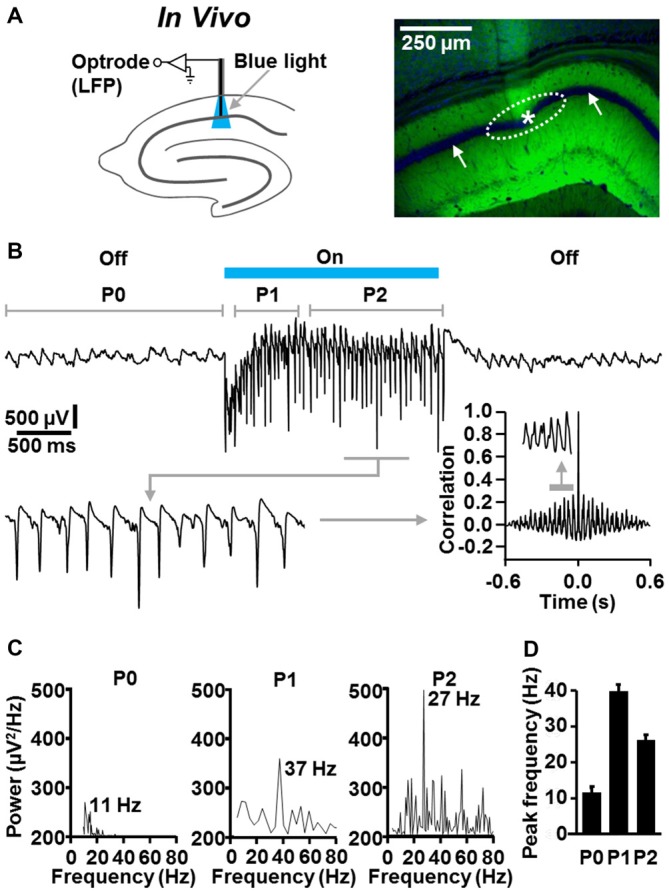
Temporally precise optogenetic induction and termination of fast CA1 network oscillations in slightly anesthetized NEX-Cre-ChR2 mice. (A) Experimental setting and photograph illustrating the position of the recording tip of the optrode (asterisk) and the calculated illumination spot in the CA1 stratum pyramidale (dotted ellipse) in the experiment shown in (B; right panel: green (EYFP-generated) fluorescence signal reports ChR2 expression; blue fluorescence signal reports nuclear DAPI staining, which is best visible in the pyramidal cell body layer (white arrows)). (B) Representative recording trace, enlarged portion of the trace, and autocorrelogram depicting the oscillatory network activity in the absence and presence of ChR2 activation by blue laser light (488 nm; 4 mW/mm2). (C) Power spectra for P0, P1, and P2 of the rhythmic network activity shown in (B). (D) Average data from spectral analyses (n = 5).